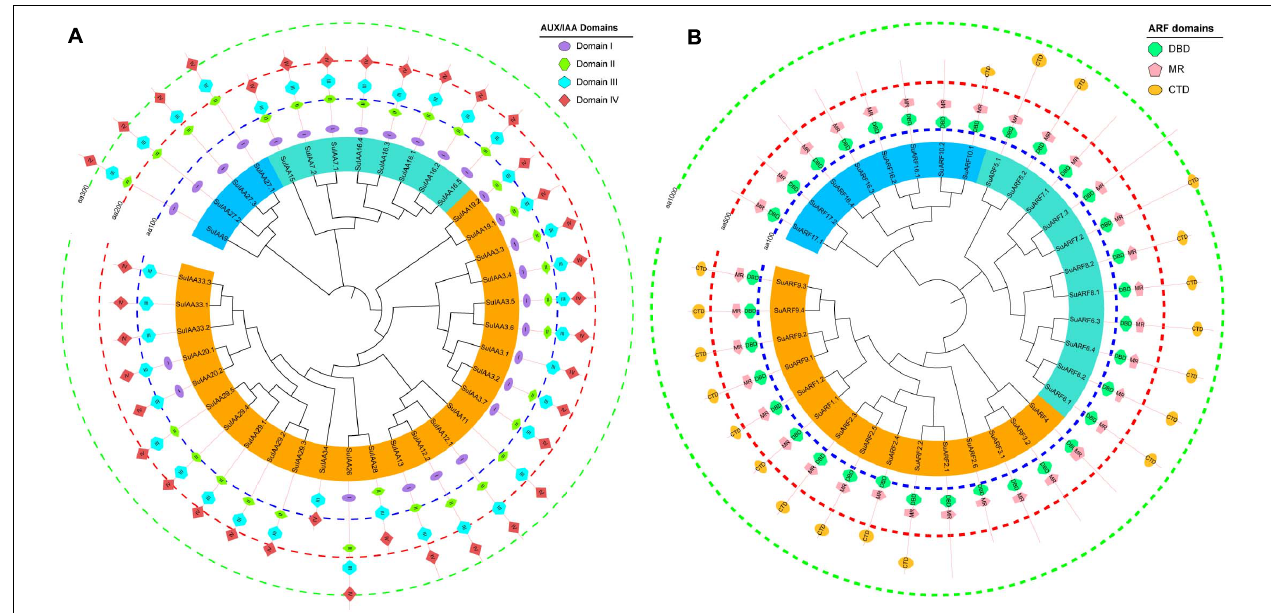
FIGURE 2 | The phylogenetic relationships and conserved domain architecture of the SuIAA and SuARF proteins. (A) The phylogenetic tree of SuIAA proteins is divided into three subfamilies, which are represented by blue, cyan, and orange arcs. Domains I–IV are shaped with ellipse, vertical hexagon, horizontal hexagon, and rhombus from inside to outside. (B) The phylogenetic tree of SuARF proteins is also divided into three subfamilies, and canonical domains DBD (DNA-binding domain), MR (middle region), and CTD (C-terminal dimerization domain) are separately drawn with octagon, pentagram, and eclipse. Three dashed concentric circles of different colors are used to indicate the scale of the SuIAA and SuARF proteins